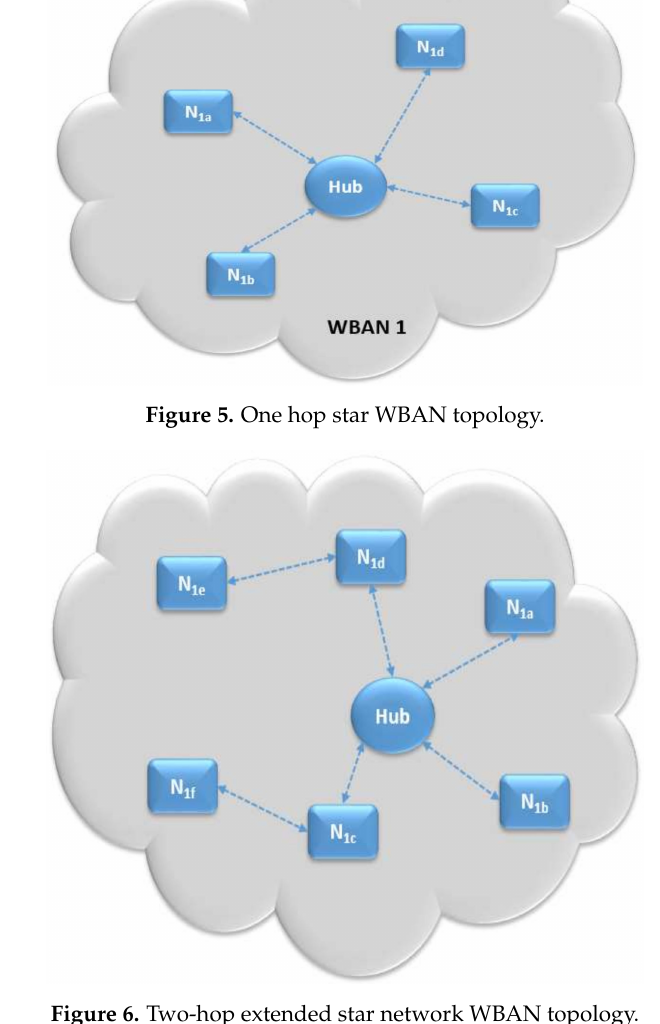
Figure 6. Two-hop extended star network WBAN topology.